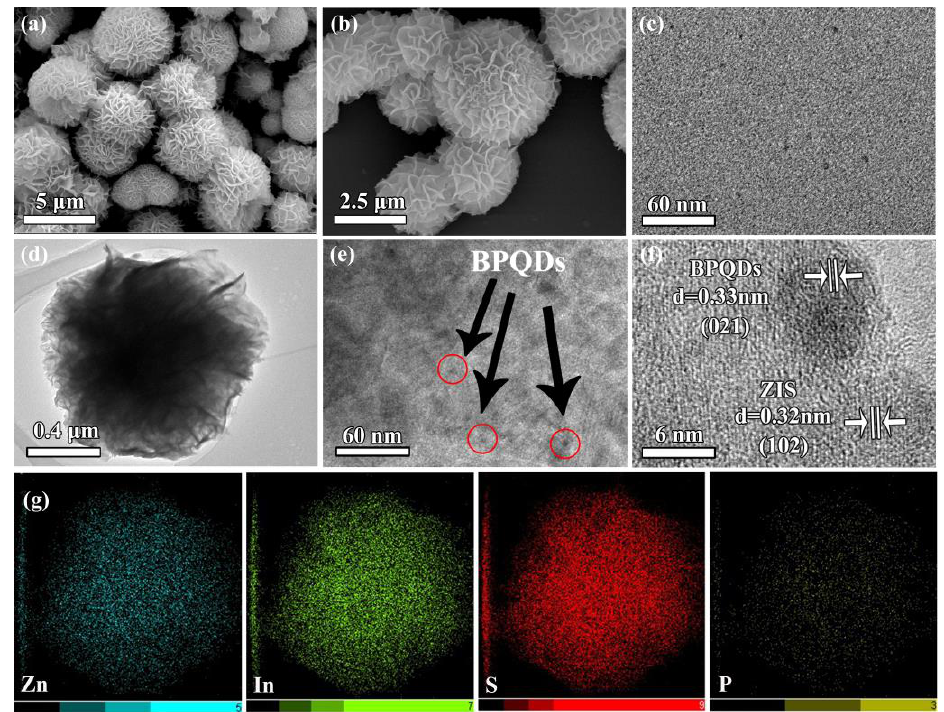
Figure 2. SEM images of ZnIn 2 S 4 ( a , b ), TEM images of BPQDs ( c ) and BPQD–ZIS ( d , e ), high-resolution